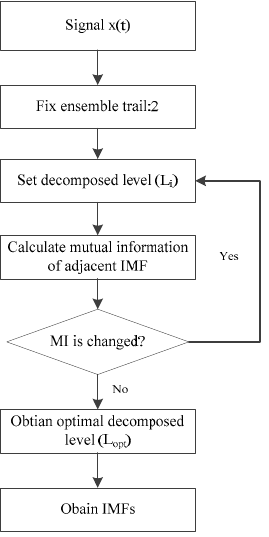
Figure 1. Flowchart of enhanced complementary empirical mode decomposition with adaptive noise (ECEEMDAN).